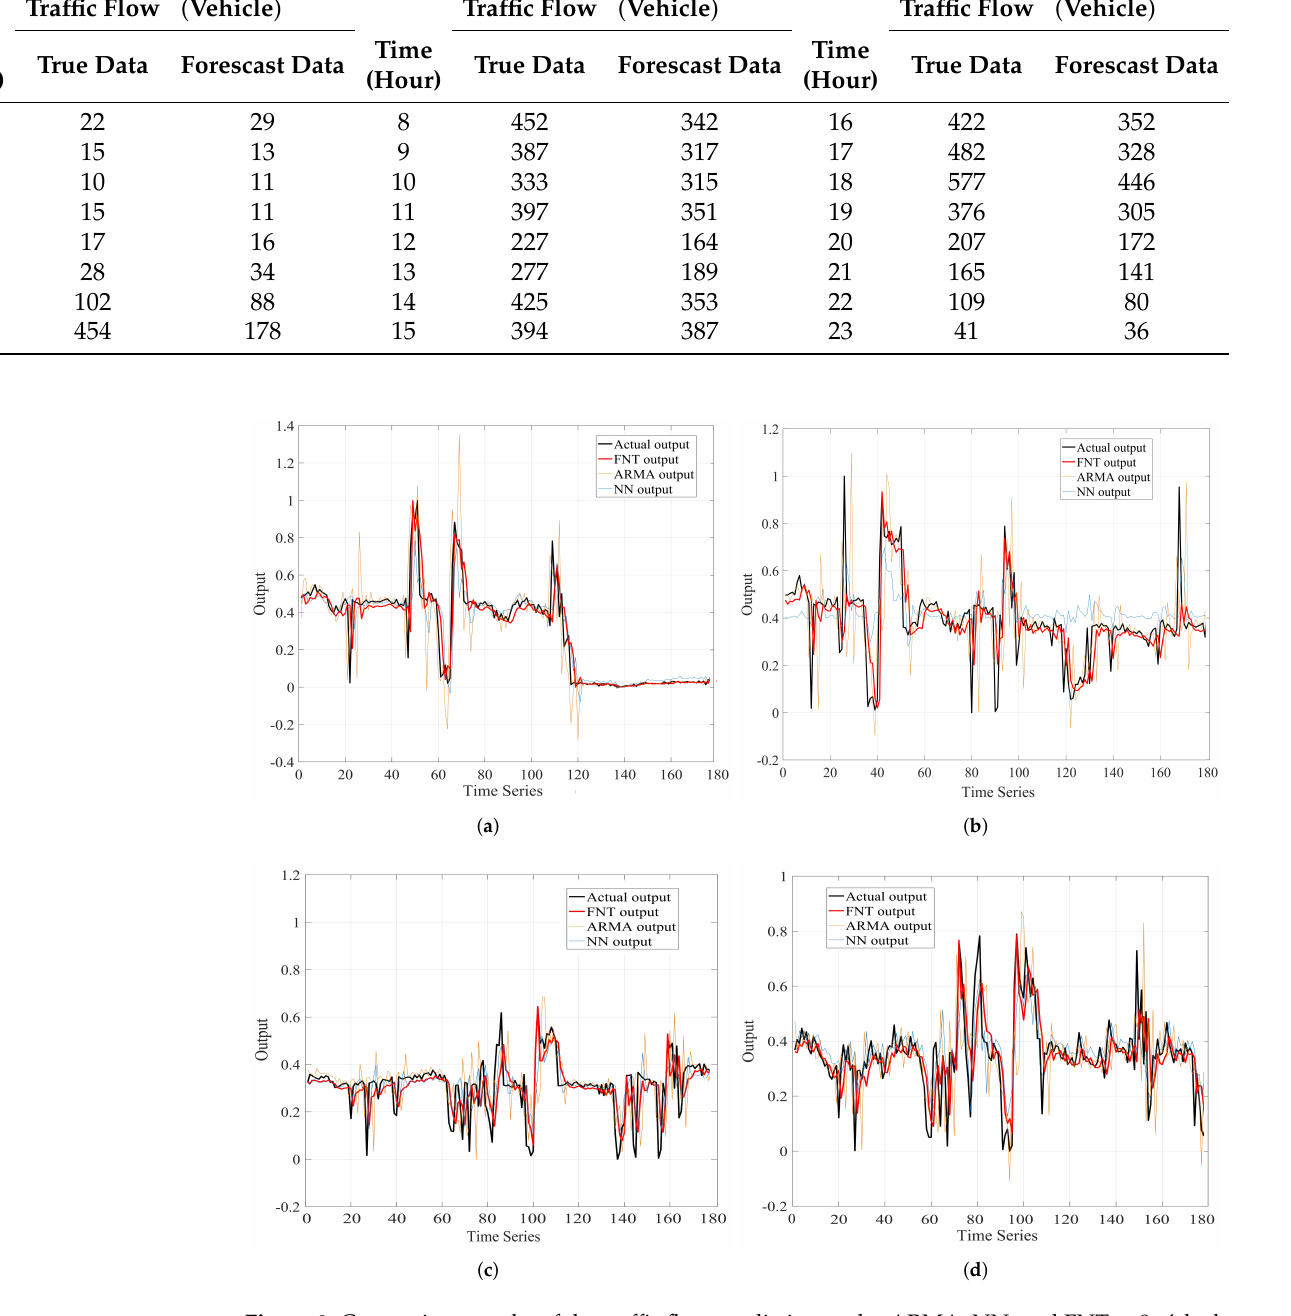
Figure 8. Comparison results of the traffic flow prediction under ARMA, NN, and FNT at 8 o’clock. ( a ) The comparison results of traffic flow prediction on gate 2. ( b ) The comparison results of traffic flow prediction on gate 5. ( c ) The comparison results of traffic flow prediction on gate 7. ( d ) The comparison results of traffic flow prediction on gate